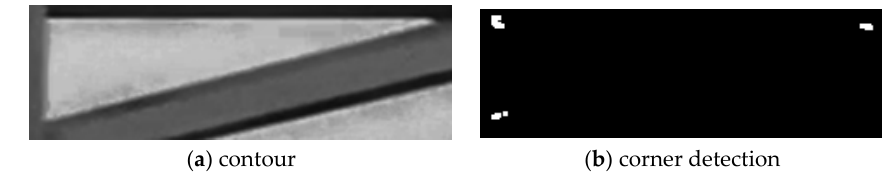
Figure 2. Results of corner detection.